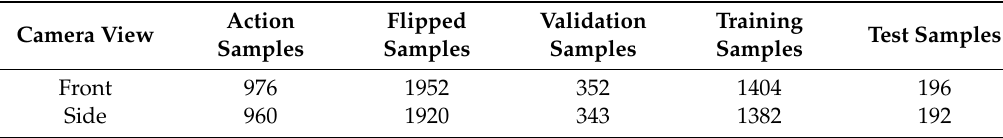
Table 3. Types and number of training and test samples.